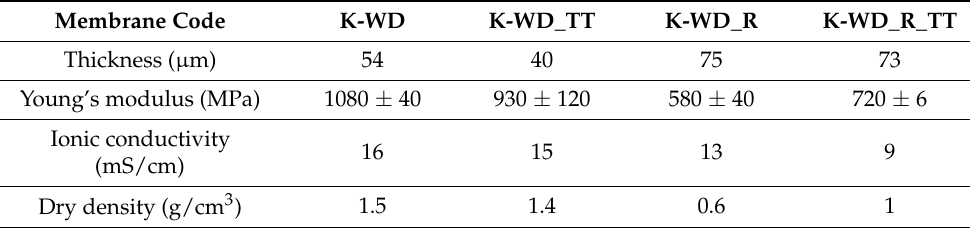
Figure 5. Swelling data of K-WD membranes. Table 3. Fully hydrated thickness, Young’s modulus, ionic conductivity and dry density of K-WD